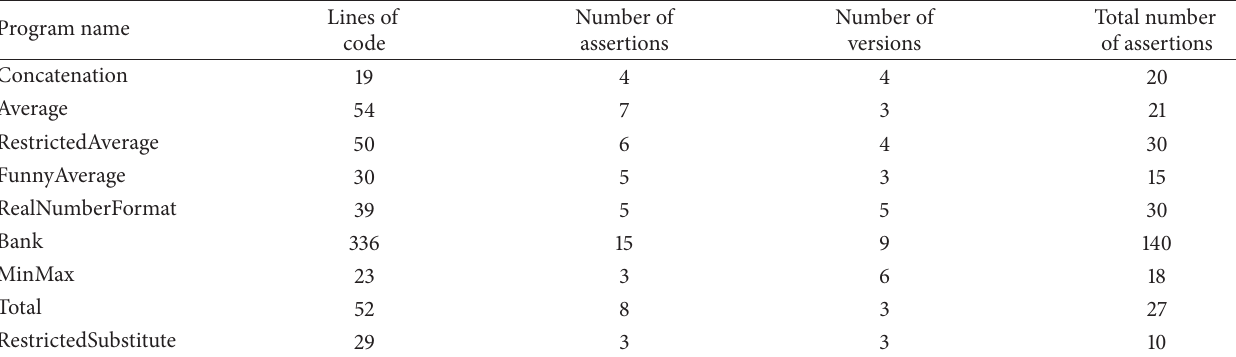
Table 1: Programs used in the case